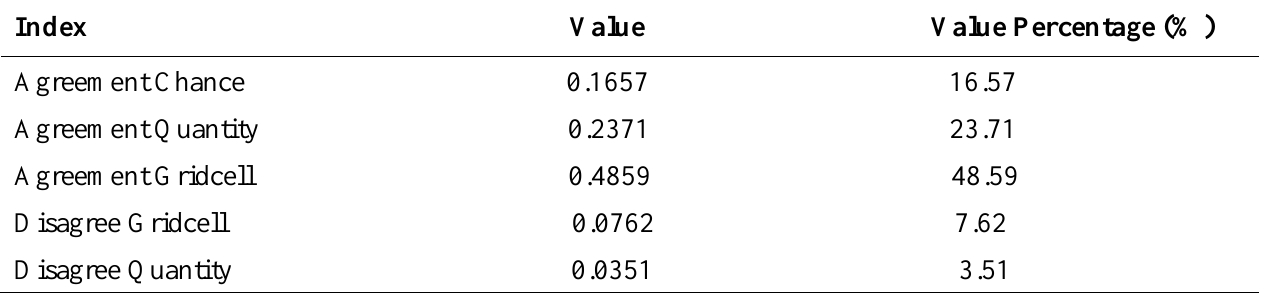
Table 8 . The k-index values of the simulated LULC map of 2019.